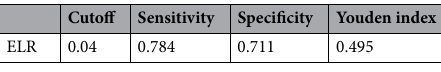
Table 4. The cutoff of the